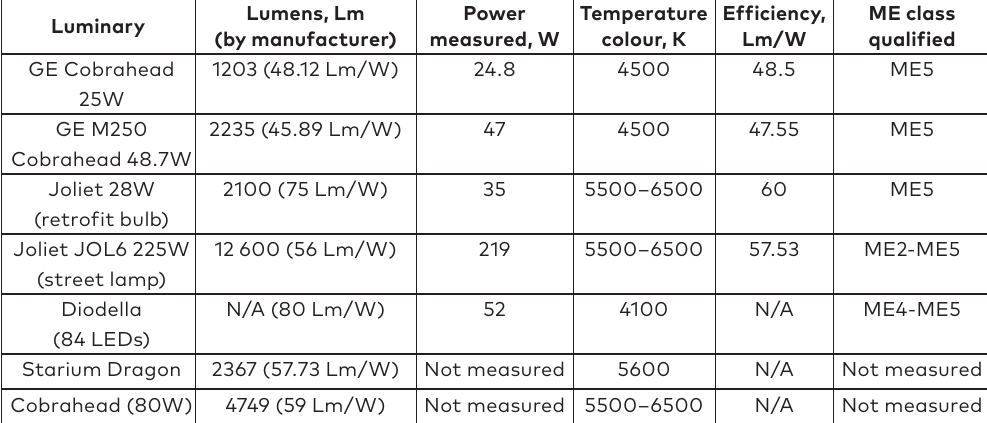
Table 2. The main parameters of SMD/SMT based LED luminary tested in LAB and Riga PilotSite in 2009